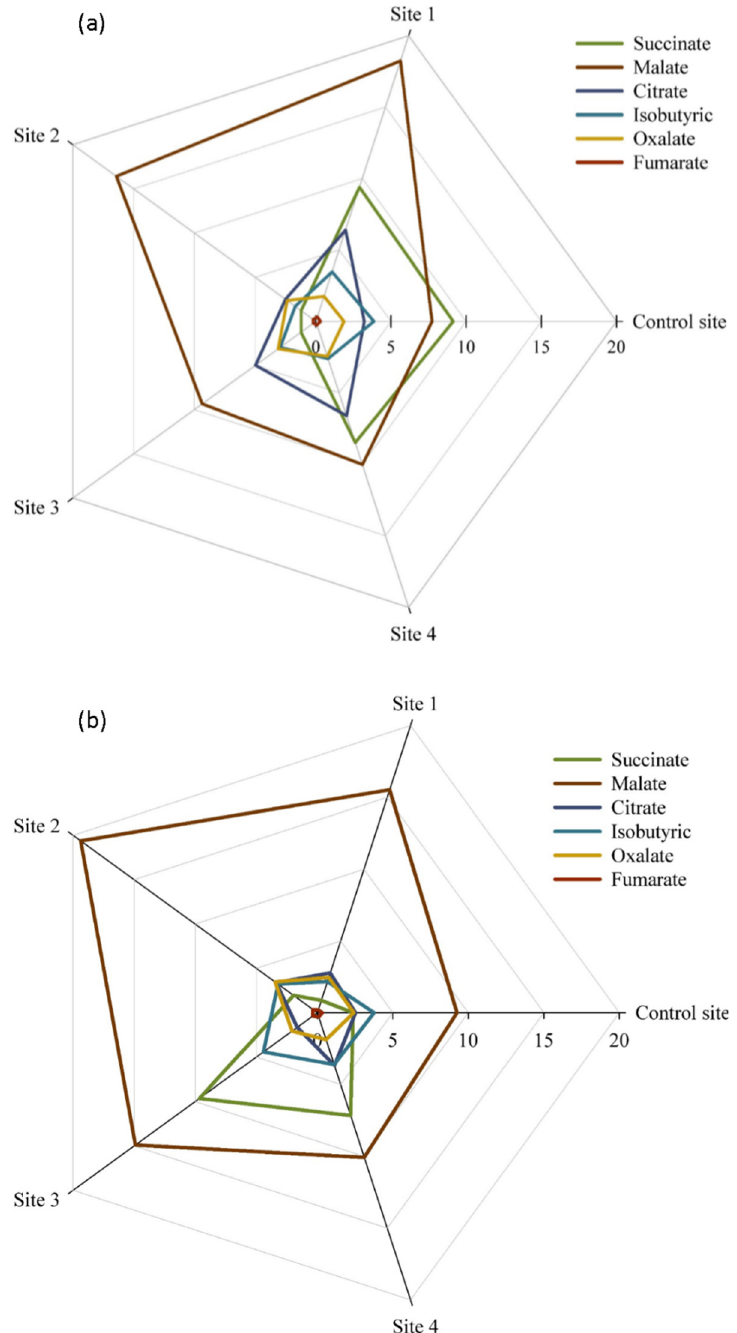
Figure 7. The concentration of organic acids (ng g − 1 ) in the shoot ( a ) and root ( b ) of S. portulacastrum plants at different levels of heavy metals pollution.